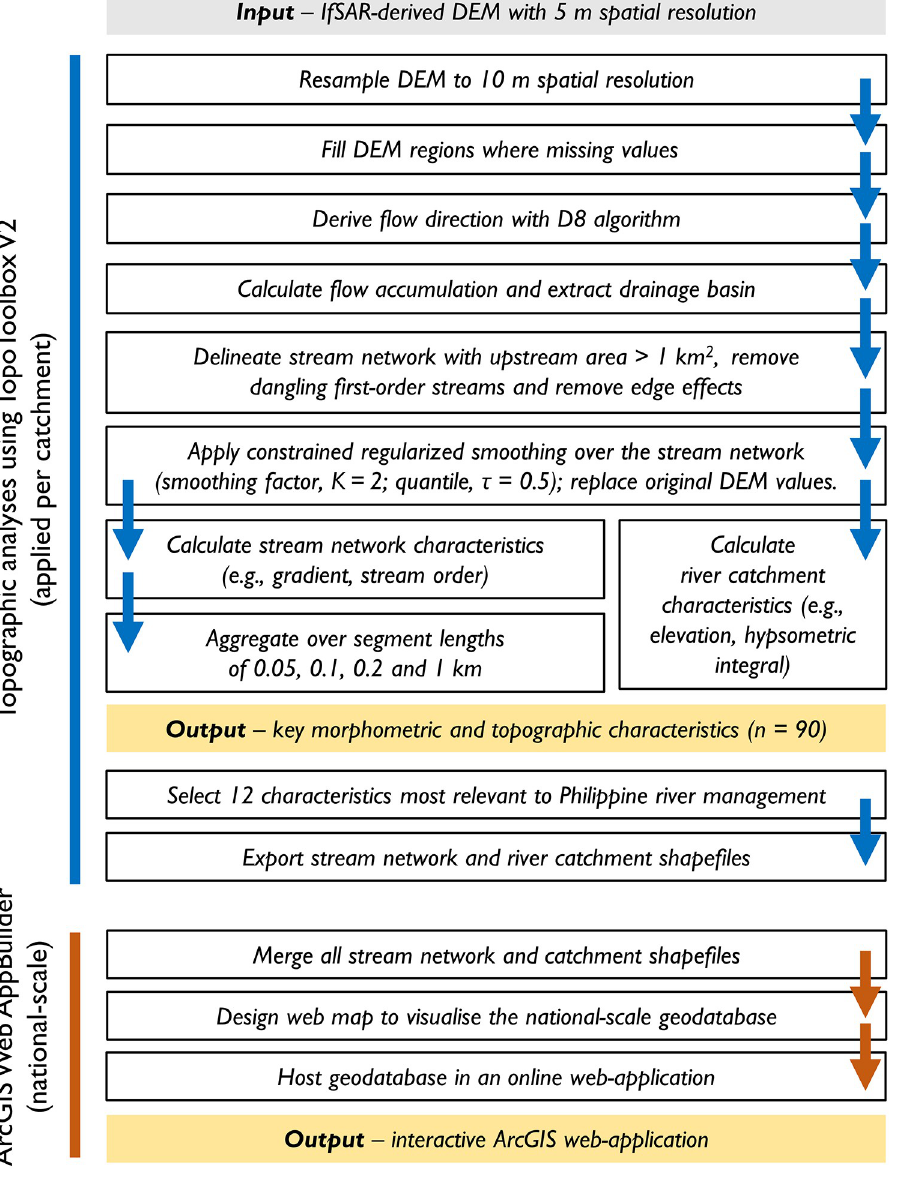
Fig 1. Workflow for calculating fundamental topographic characteristics of stream networks and river catchments from a DEM and displaying results in an interactive ArcGIS web-application.